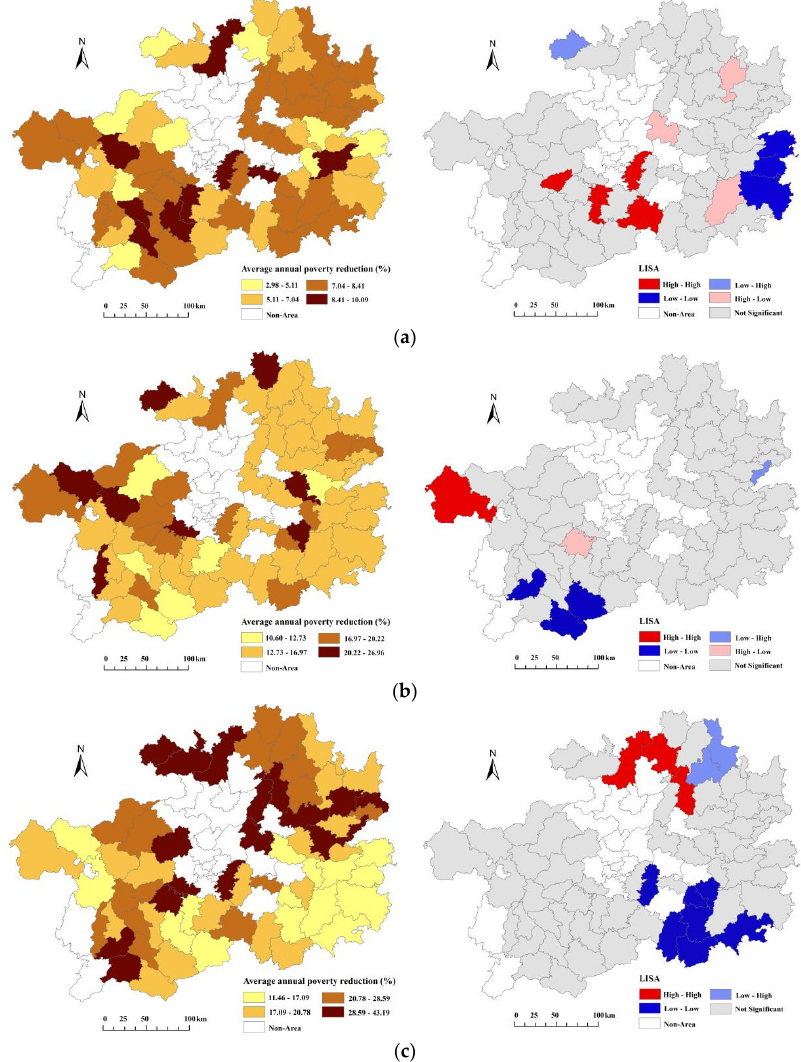
Figure 4. Map of the average annual poverty reduction and LISA analysis in the three research pe- riods. ( a ) 2003–2007. ( b ) 2008–2010. ( c ) 2011–2017.